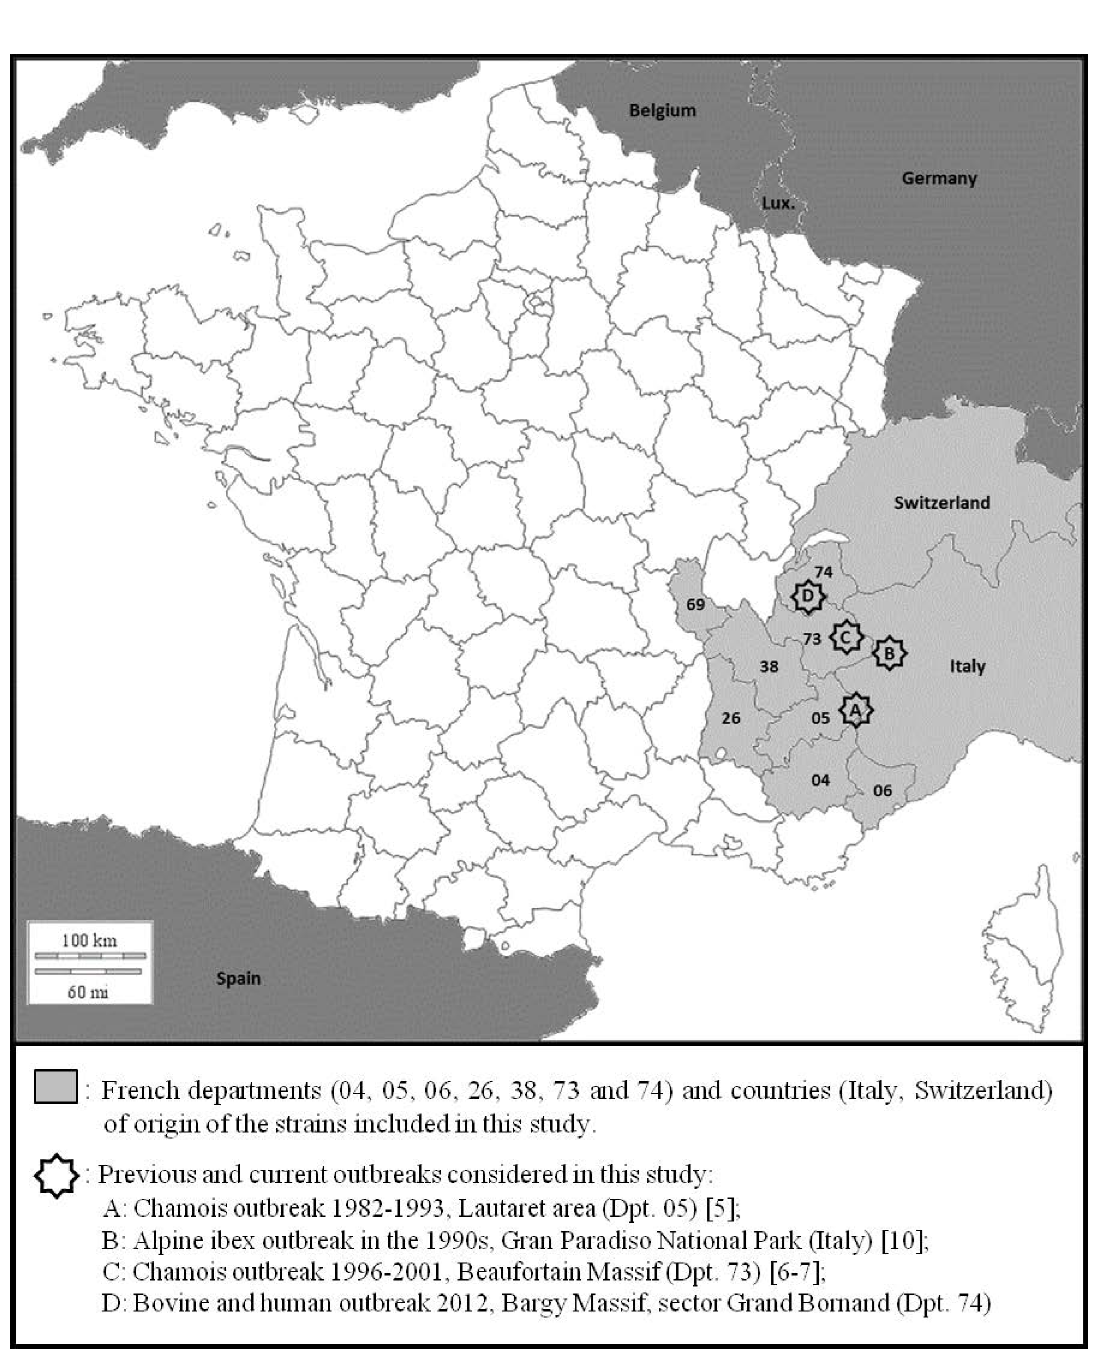
Figure 1. Survey area with current and previous Brucellamelitensis bv 3 outbreaks in wild ungulates in the Alps.